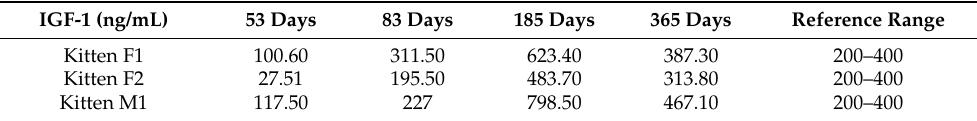
Table 2. The IGF-1 concentrations at diagnosis (53 days) and during the follow-up examinations.